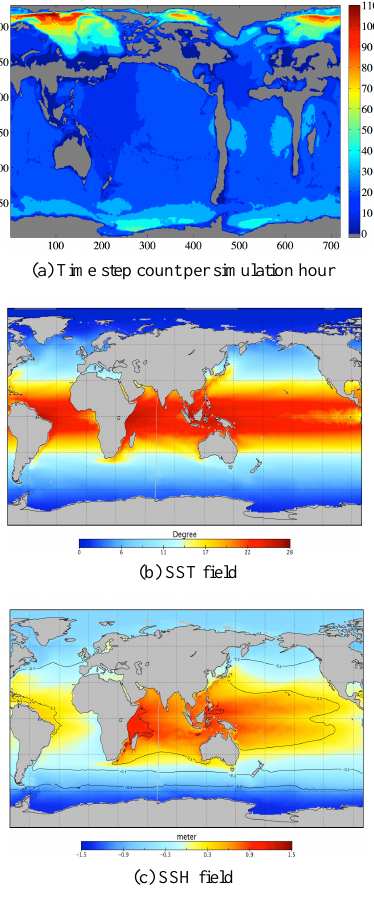
Figure 14. Model evaluation of sample grids with MCSC